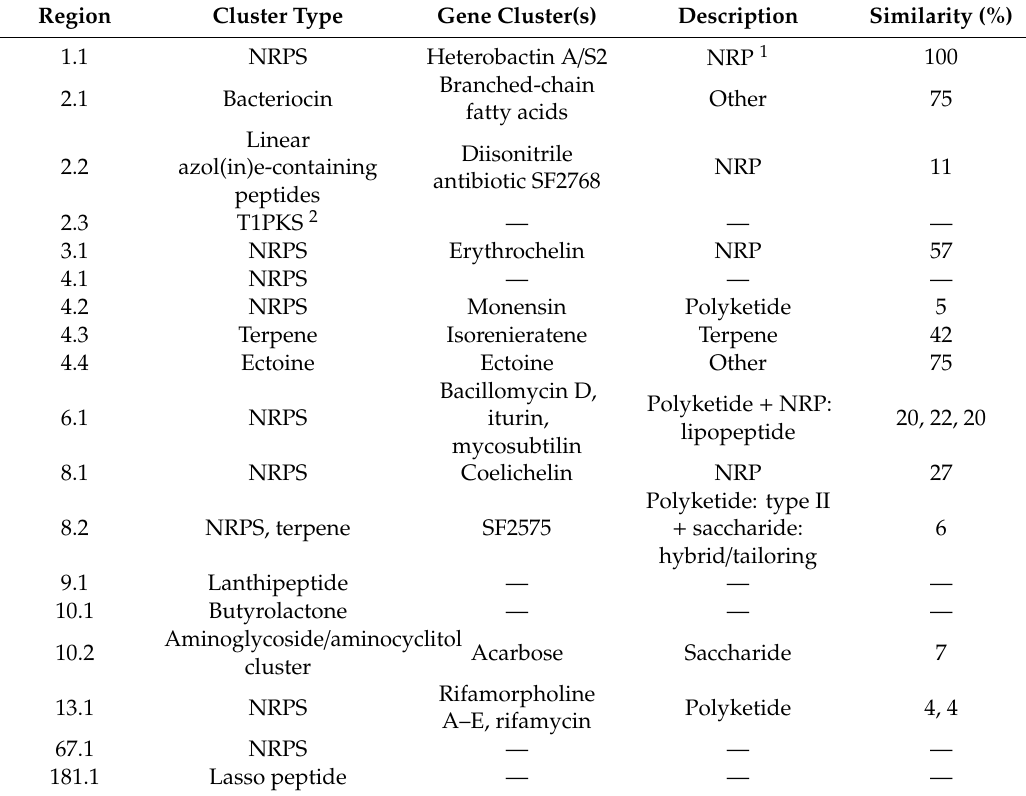
Table 2. The distribution of biosynthetic gene clusters in the Rhodococcus sp.